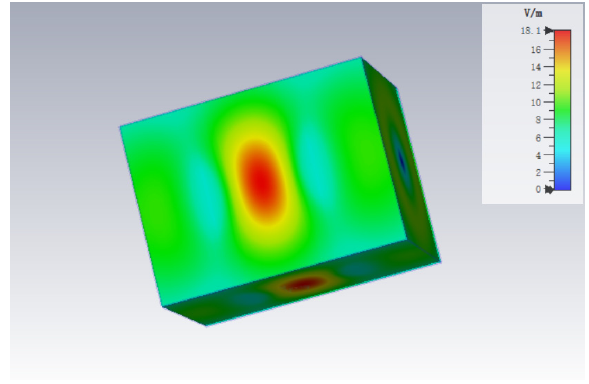
Figure 5. Near-field disturbance source generated by a wire antenna.